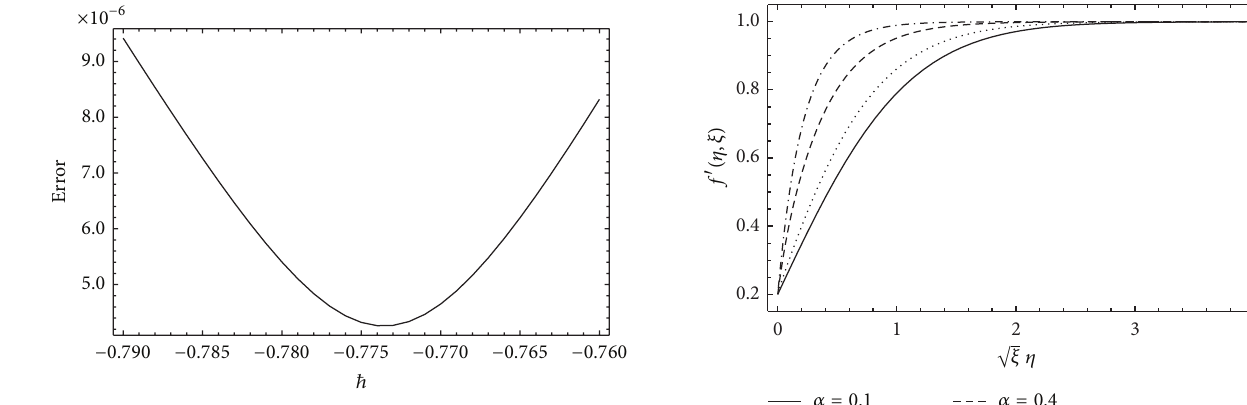
Figure 2: Squared relative error for the optimal values of ℎ for 𝛼 = 0.1 by keeping 𝜉 = 0.8 , 𝜆 = 0 , and 𝛽 = 5 fixed.